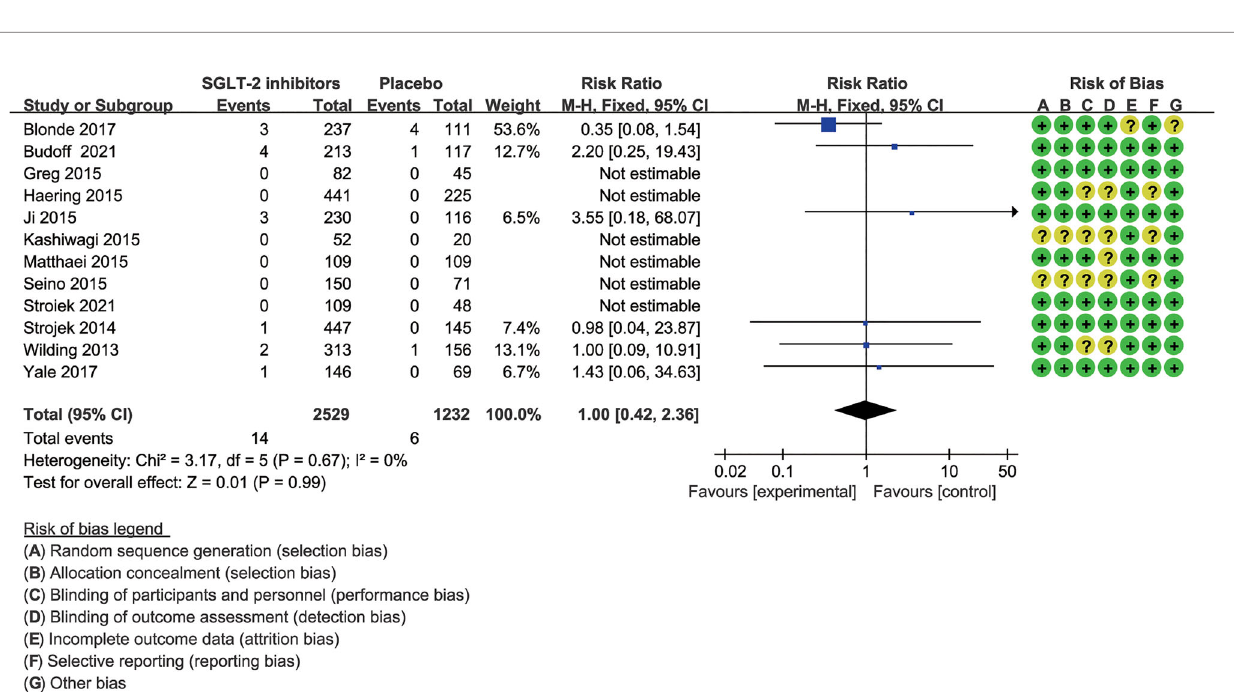
FIGURE 4 | Risk of hypoglycemia in trials with the same de fi nition of hyperglycemia. Forest plot showing risk of hypoglycemia in patients treated with SGLT-2 inhibitors plus sulfonylureas compared with placebo plus sulfonylureas (Trials with different or not report a de fi nition of hypoglycemia were